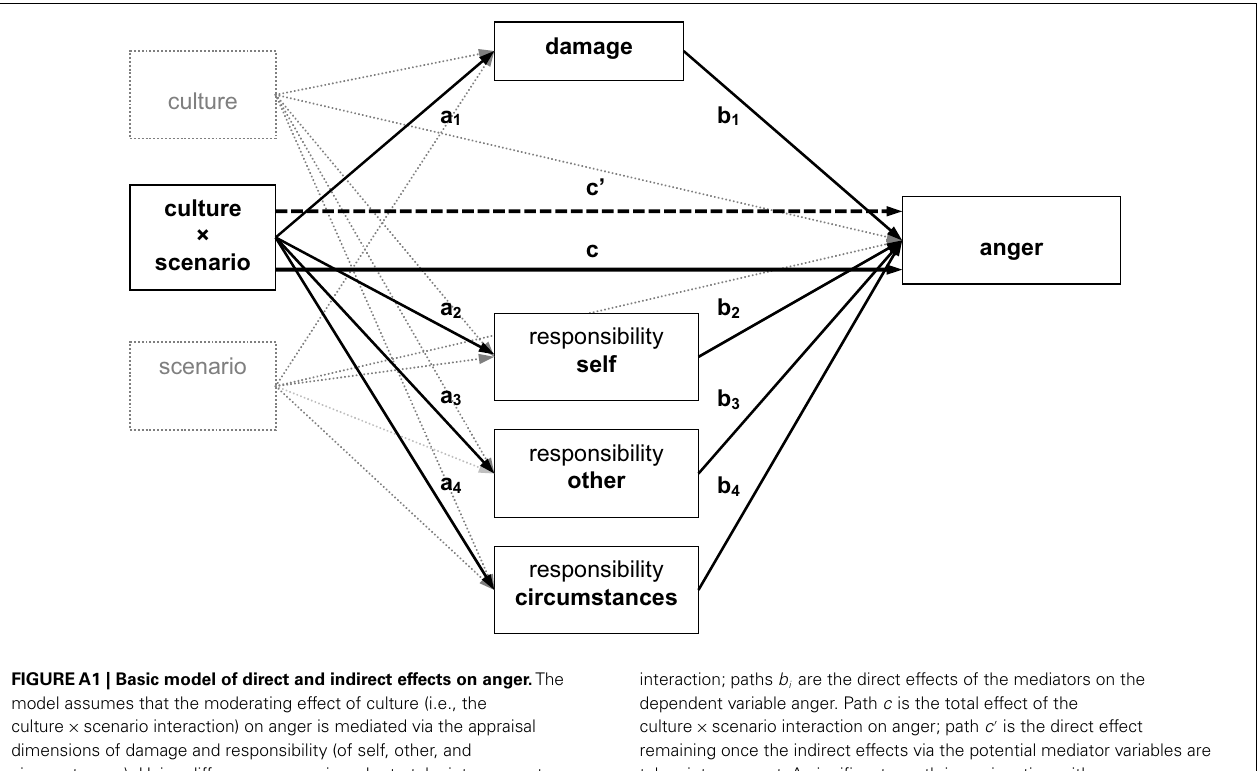
FIGUREA1 | Basic model of direct and indirect effects on anger. The model assumes that the moderating effect of culture (i.e., the culture × scenario interaction) on anger is mediated via the appraisal dimensions of damage and responsibility (of self, other, and circumstances). Using difference scores in order to take into account our within-subjects design, we effectively tested the simplified model printed in black. Paths a i designate the direct effects of the culture × scenario